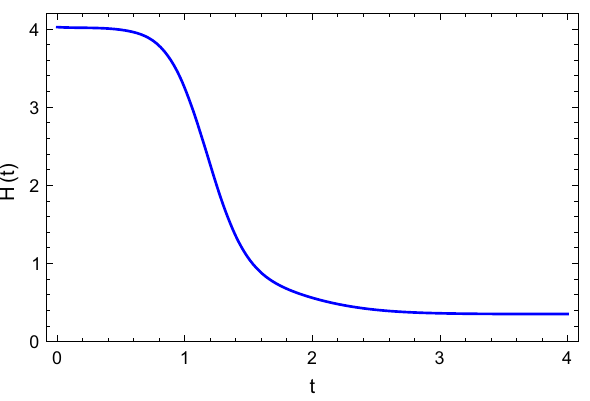
Fig. 8 Behavior of the equation of state for Model III , with c 0 = 1 . 00015, λ 1 = 2 . 25, λ 2 = 4 . 5, λ 3 = 0 . 00005, and α 3 = − 7 . 02